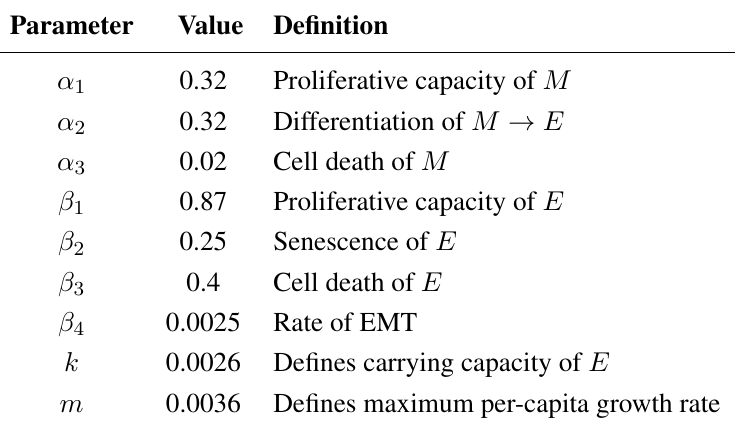
Table 1. The parameters that describe the linear and saturated feedback model. The values given are those used for the simulation of the saturated feedback model. The units of all of the α and β are [1 /div ] , where div is the time for one cell division in days. The unit of k is [1 /Ndiv ] , and the unit of m is [1 /N ] , where N is the number of cells of species E at time t . EMT, epithelial-mesenchymal